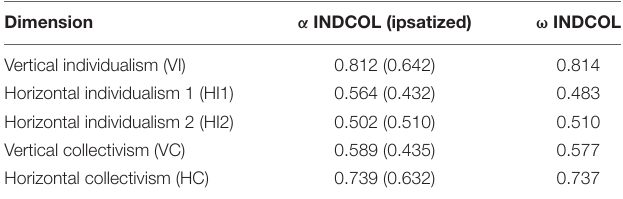
TABLE 6 | Reliability estimations of the Czech version of the INDCOL subscales. Dimension α INDCOL